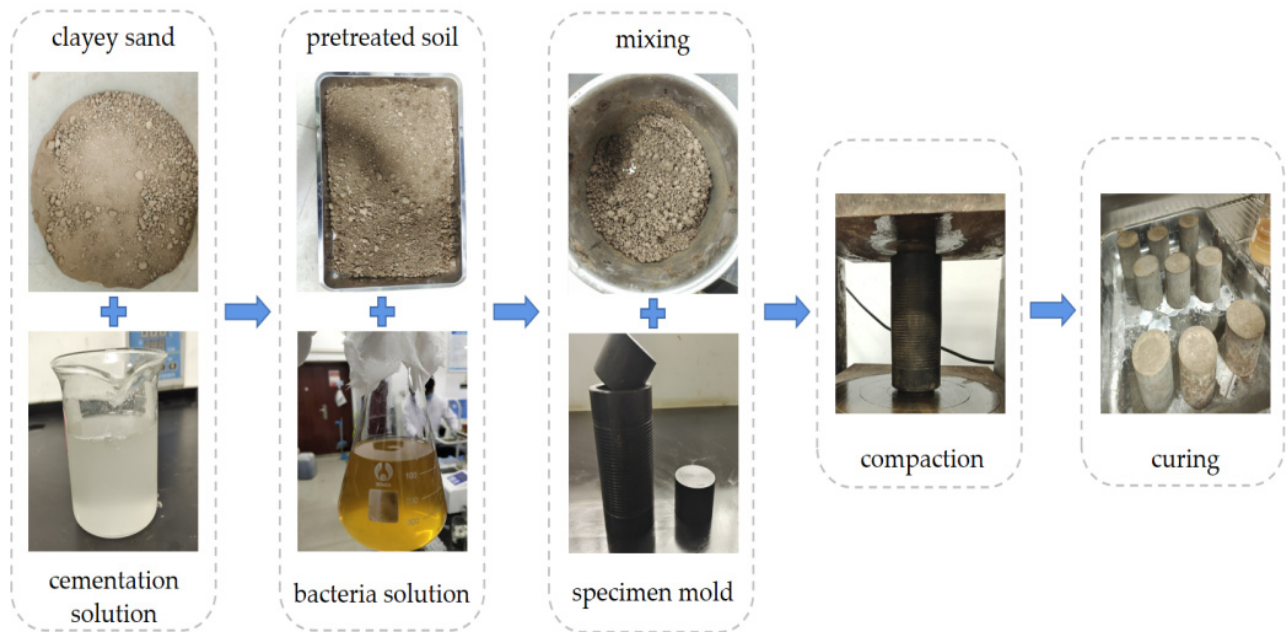
Figure 2. The specimen preparation of UCS test.